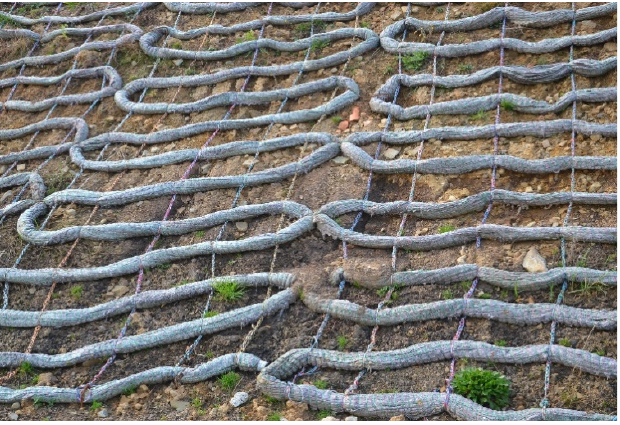
Figure 1. The segments of ropes arranged in a meander-like pattern that were installed on the slope.